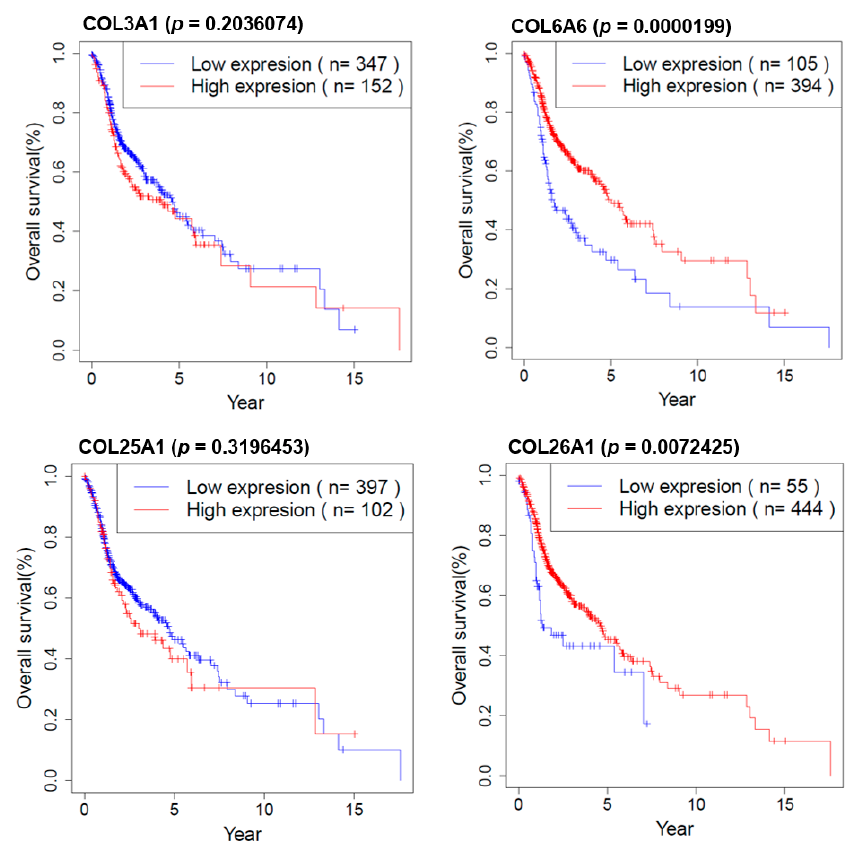
Figure 8. Kaplan–Meier survival plots for HNSCC patients according to COL genes.